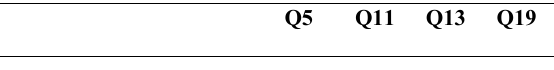
Table 4. Heuristic Information about Agents in the Teaching